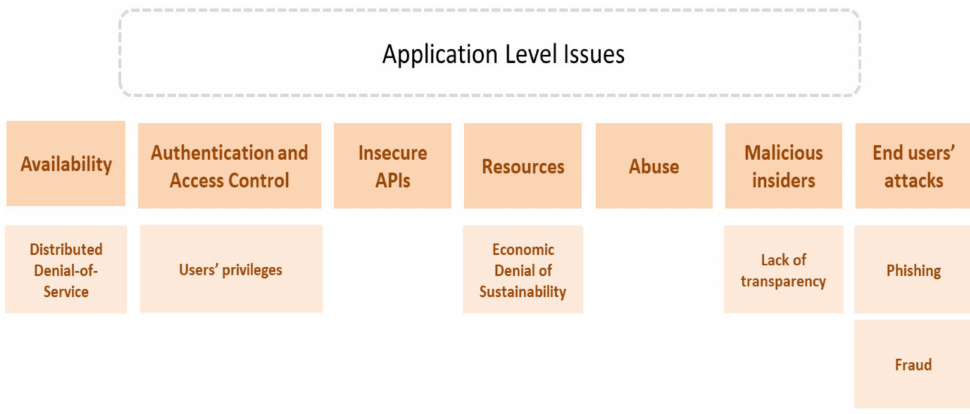
Figure 8. Application-level